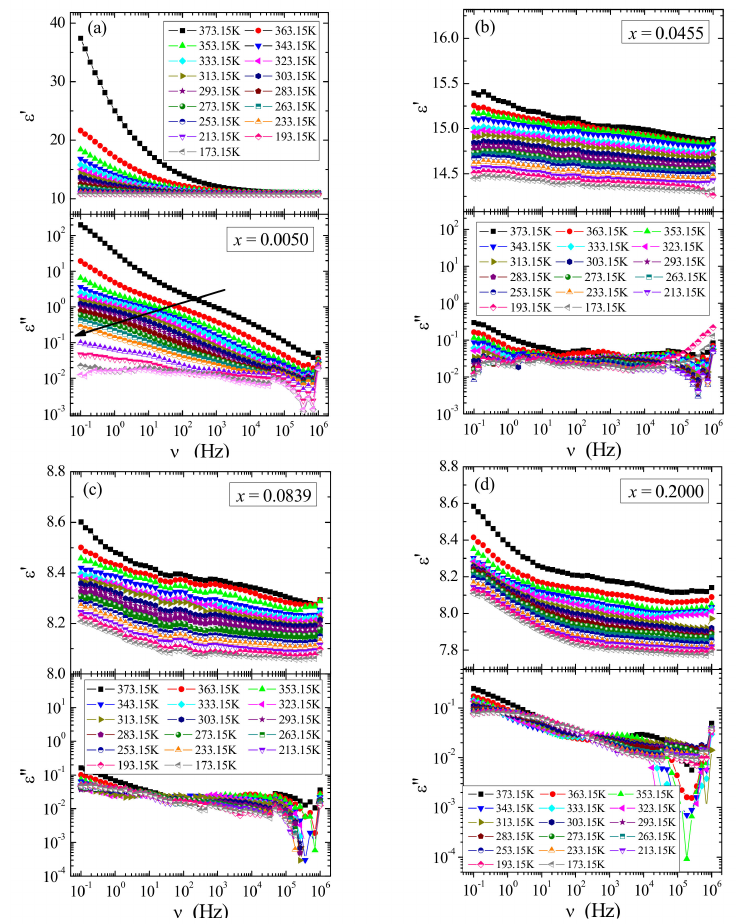
Figure 12. Real ( ε (cid:48) ) and imaginary ( ε ”) part of permittivity vs. frequency ν of CCGMWO solid solution for x = 0.0050 ( a ), 0.0455 ( b ), 0.0839 ( c ), and 0.2000 ( d ) recorded in the temperature range of 173–373